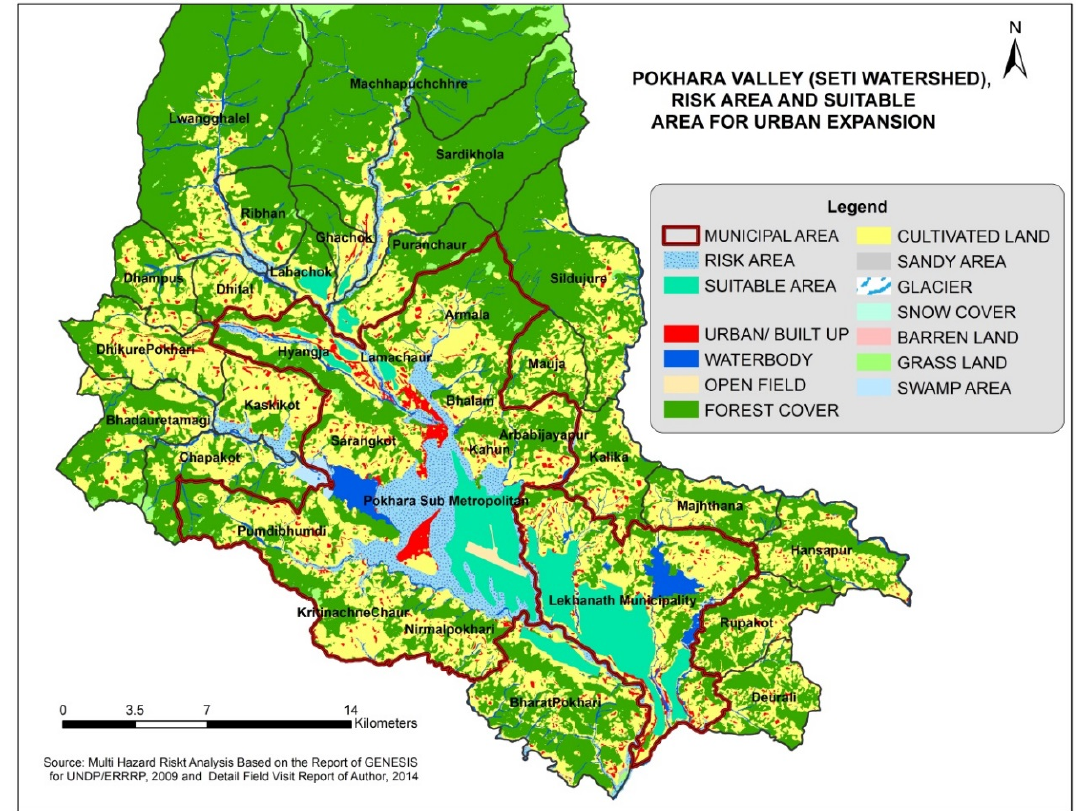
Figure 13. Map for risk areas and suitable places for urban